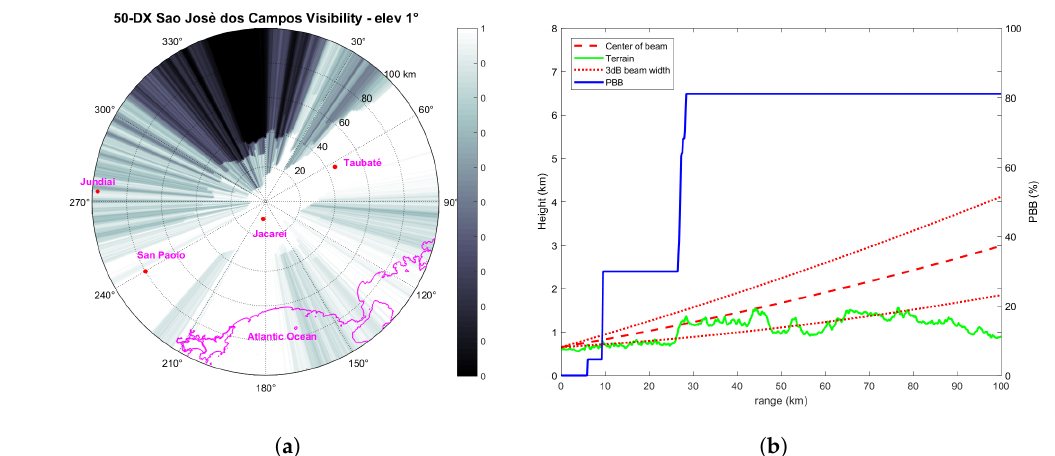
Figure 5. ( a ) Map of radar visibility in Vale do Paraíba (black, no visibility and white, full visibility) for the 1 ◦ elevation and ( b ) profile of the beam, PBB and DEM along a given azimuth (330 degrees). Maximum range is 100